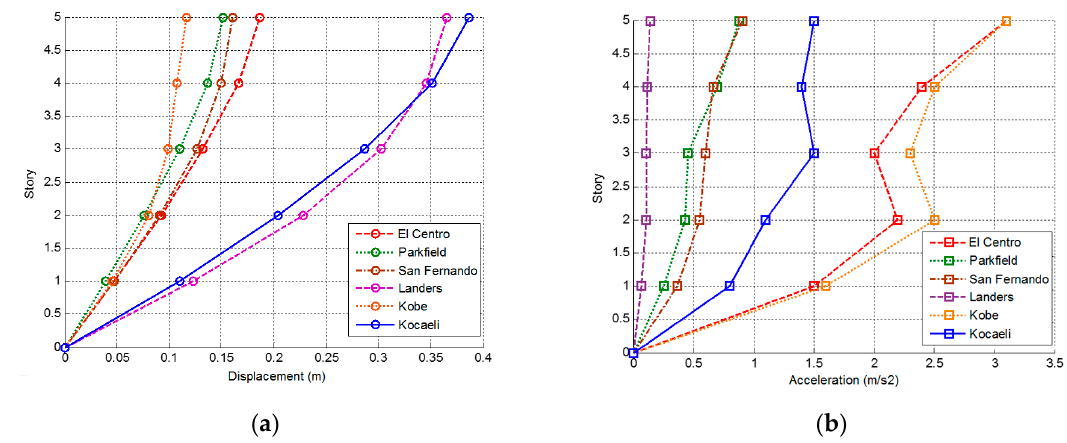
Figure 2. The results of ( a ) peak displacement and ( b ) peak acceleration for different stories of the building.